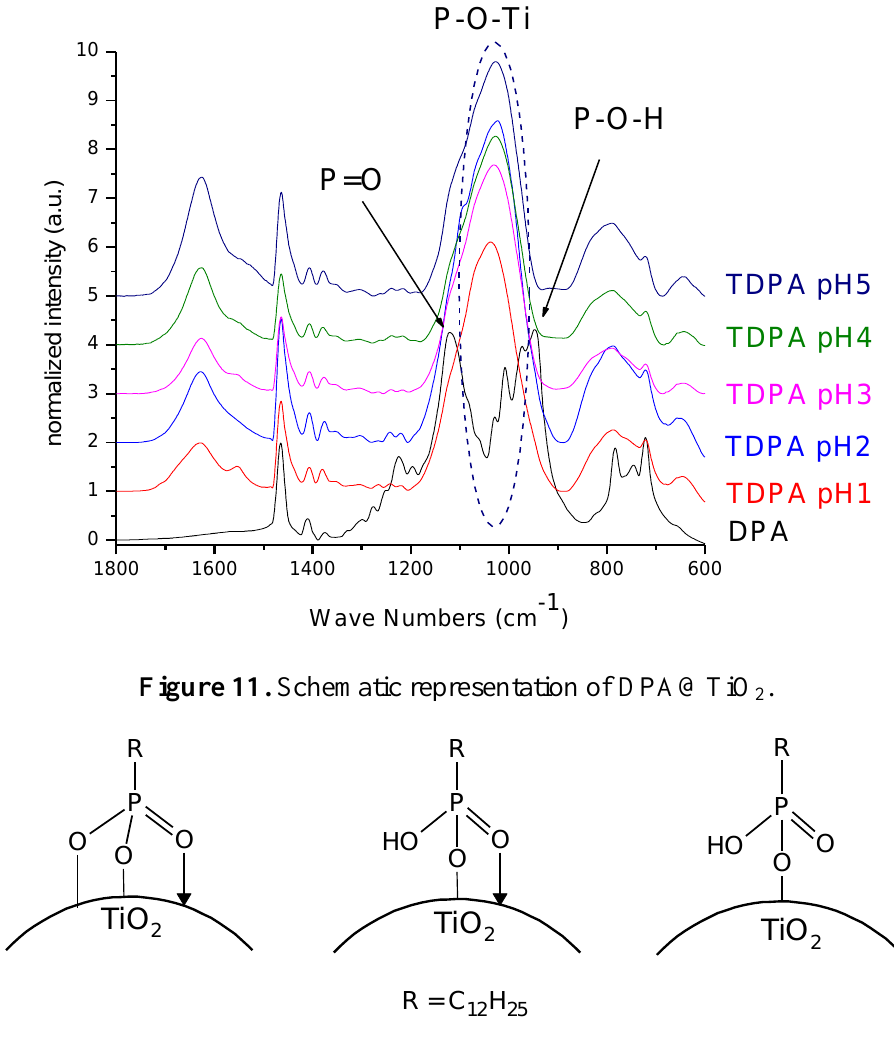
at pH 1, 2, 3, 4 and 5. 2